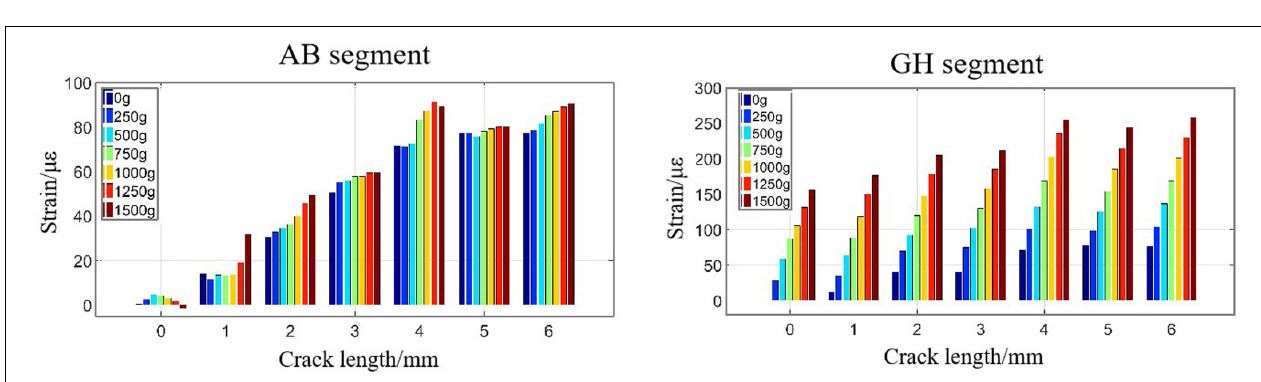
FIGURE 11 | The effect of load under 5 mm crack on the DI value of distributed optical fiber segments (AB, CD, EF, GH).